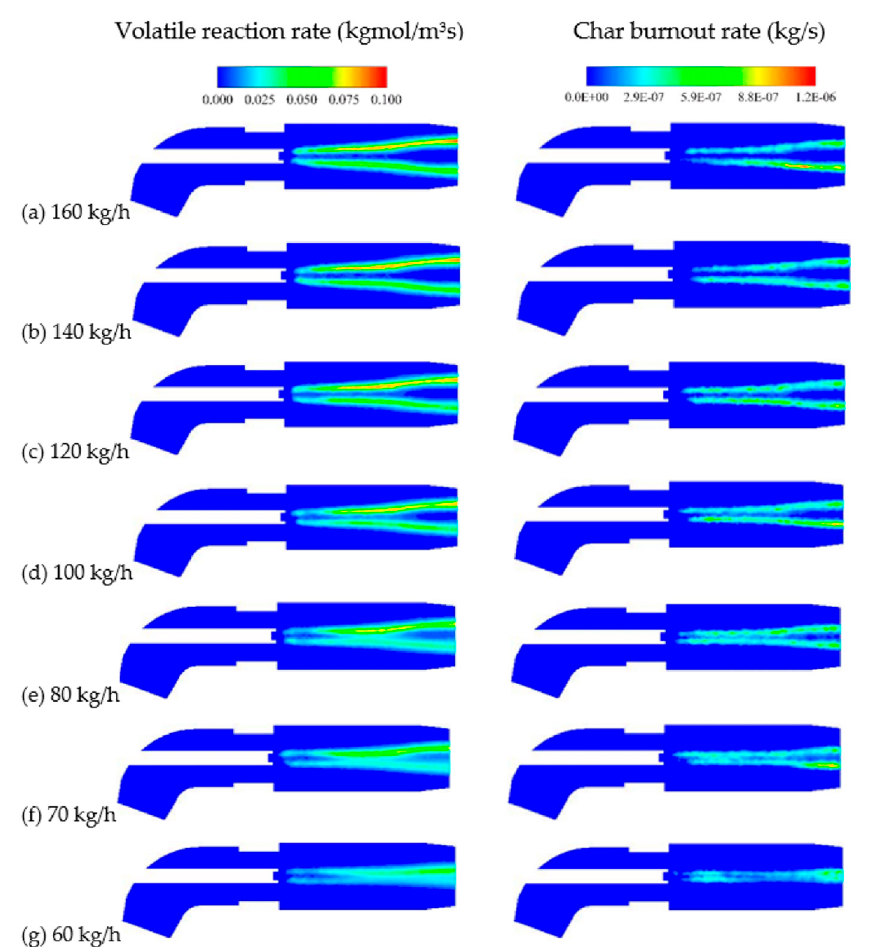
Figure 14. Volatile reaction rate and char burnout rate at the longitudinal cross section (XZ central cross section) under different oil feed rates. ( a ) 160 kg/h, ( b ) 140 kg/h, ( c ) 120 kg/h, ( d ) 100 kg/h, ( e )